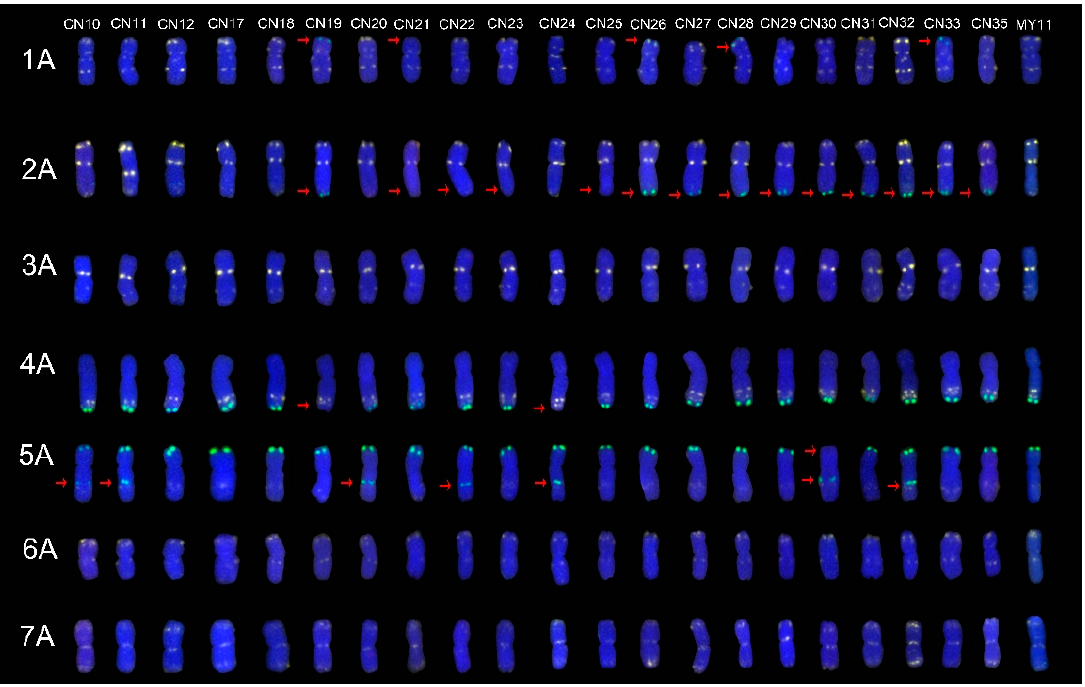
Figure 1. The ND-FISH (non-denaturing fluorescence in situ hybridization) results of A-genome chromosomes of all materials. From left to right: CN10, CN11, CN12, CN17, CN18, CN19, CN20, CN21, CN22, CN23, CN24, CN25, CN26, CN27, CN28, CN29, CN30, CN31, CN32, CN33 and CN35, respectively. From top to bottom: 1A, 2A, 3A, 4A, 5A, 6A and 7A chromosome, respectively. The red arrows showed the mutant signal patterns on chromosomes. Yellow: Oligo-pTa535-1; Green: Oligo-pSc119.2-1; Red: Oligo-Ku, Oligo-pSc200 and Oligo-pSc250; Blue: DAPI.